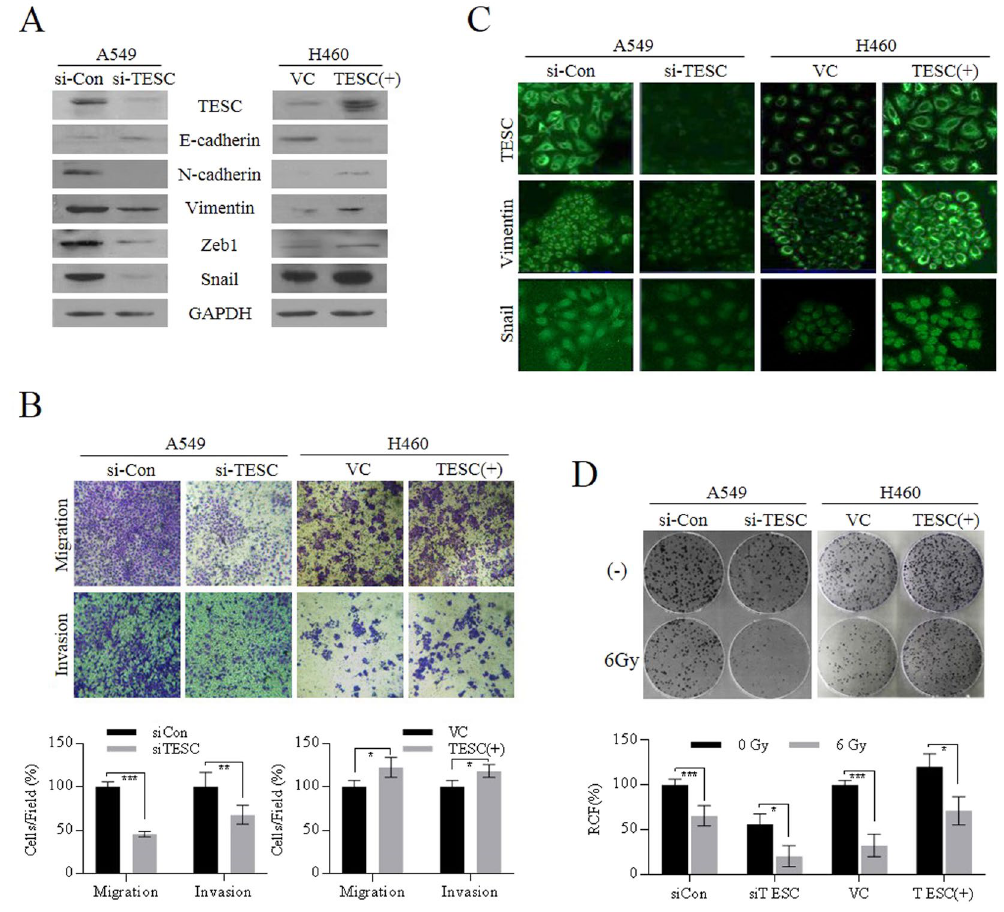
Figure 3. TESC is involved in EMT and γ -radiation resistance in lung cancer cells. ( A ) Cellular levels of EMT markers including E-cadherin, N-cadherin, Vimentin, Snail, and Zeb1 were examined in TESC -knockdown A549 cells and in TESC -overexpressing H460 cells by western blot analysis. ( B ) Invasive and migratory activities were examined in TESC -knockdown A549 cells and TESC -overexpressing H460 cells. ( C ) Changes in cellular Vimentin and Snail levels were examined in TESC -knockdown A549 and TESC -overexpressing H460 cells by immunofluorescence assay. ( D ) Colony formation in TESC - knockdown A549 cells and TESC -overexpressing H460 cells was analyzed after γ -irradiation. Data represent mean ± SD of three independent experiments using two-tailed t-test. * P < 0.05, ** P < 0.01, *** P <